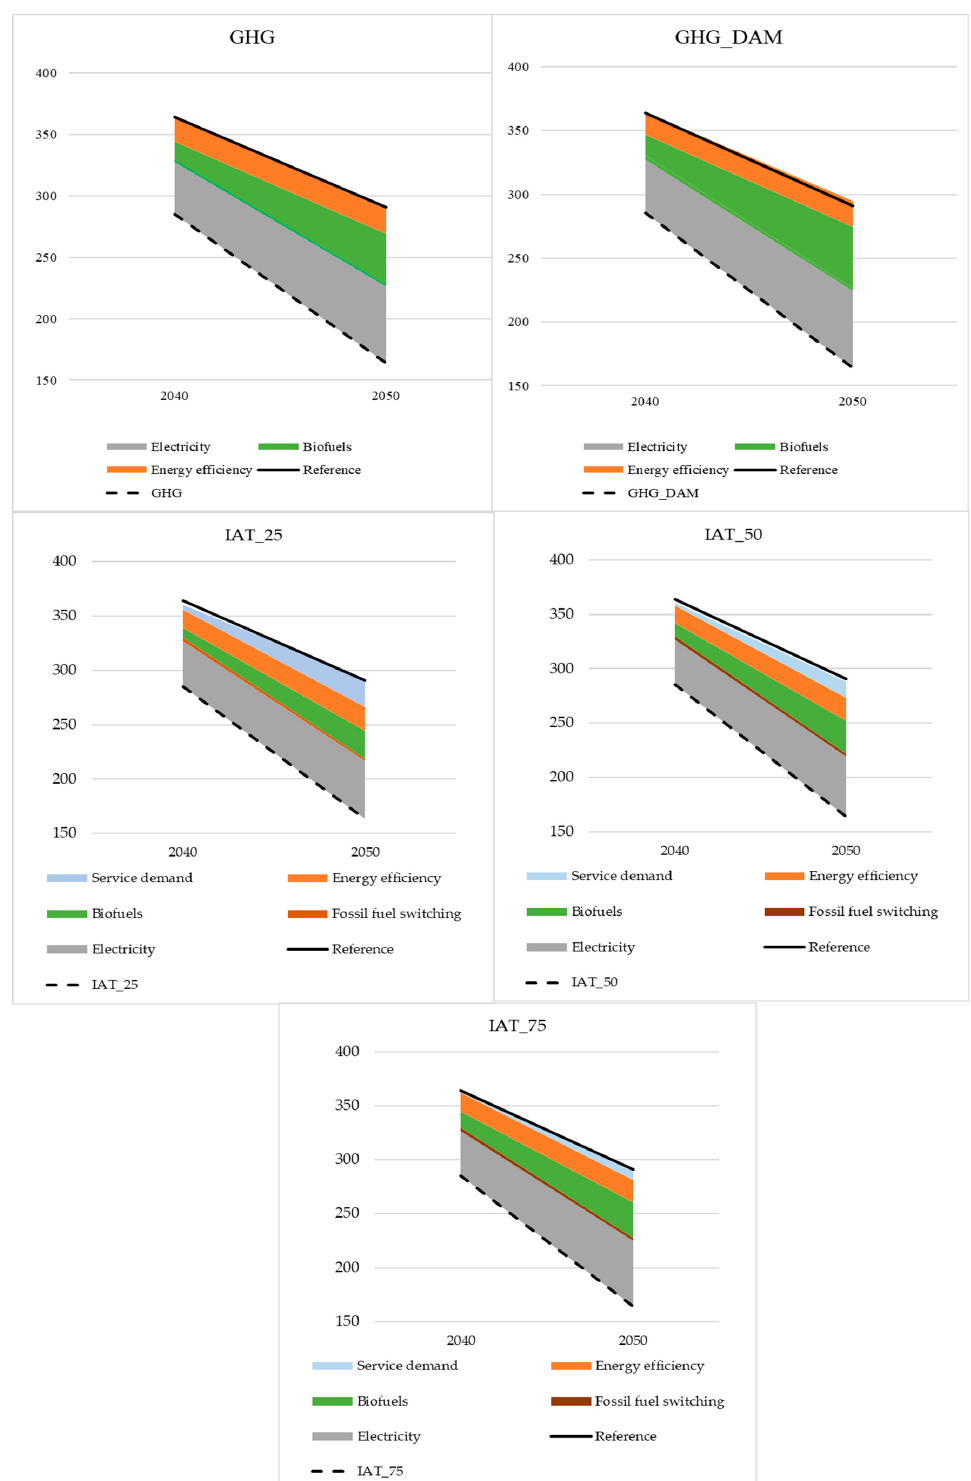
Figure C2. CO 2 decomposition (Mt) — transport in the EU-28. Figure A5. CO 2 decomposition (Mt)—transport in the